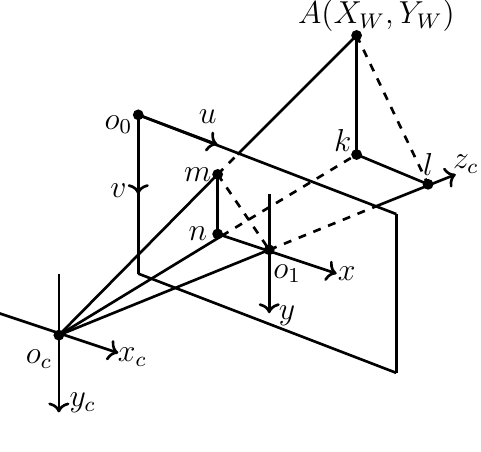
Figure 7. Similar Triangle